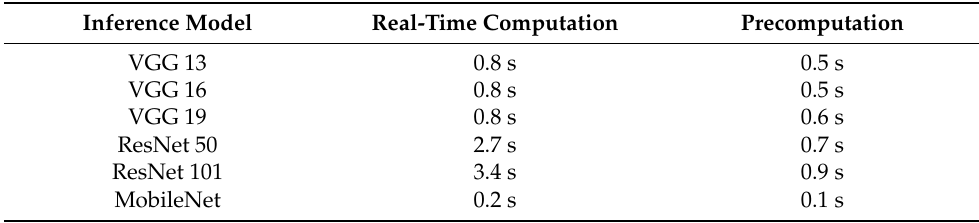
Table 7. Comparison of execution time by real-time computation and precompution.